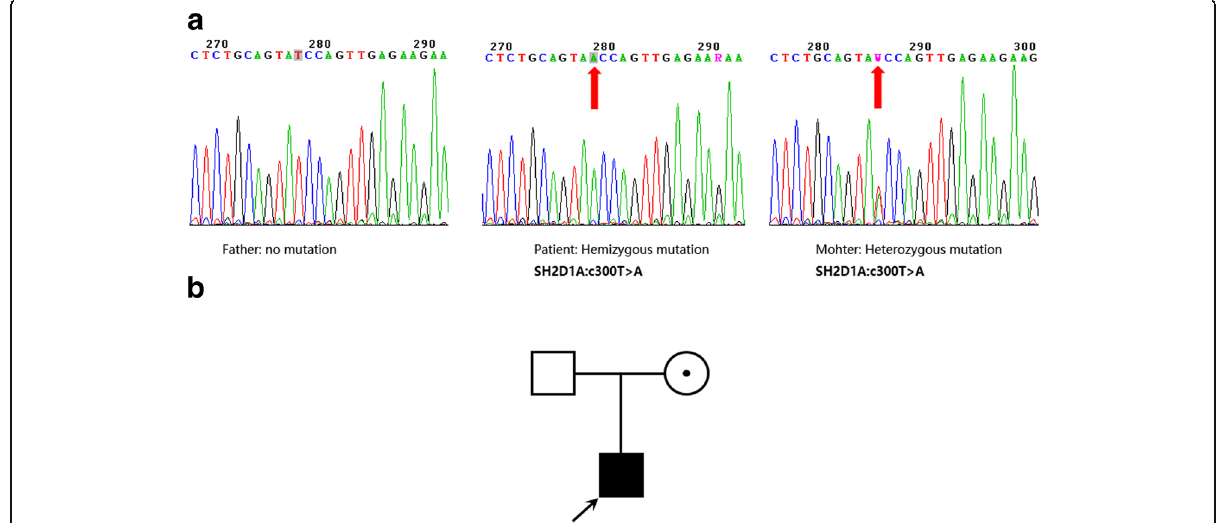
Fig. 3 Two-generation pedigree analysis. a Sanger sequencing results of the amplified fragment in SH2D1A exon 3. The red arrows indicate the position of the identified mutation. b Family pedigree of the SH2D1A mutation found in the patient. The white square represents the father who is normal in this case, the white circle with a dot represents the mother who is a carrier of the X-linked recessive genetic disorder, the black square with an arrow represents the patient who is the